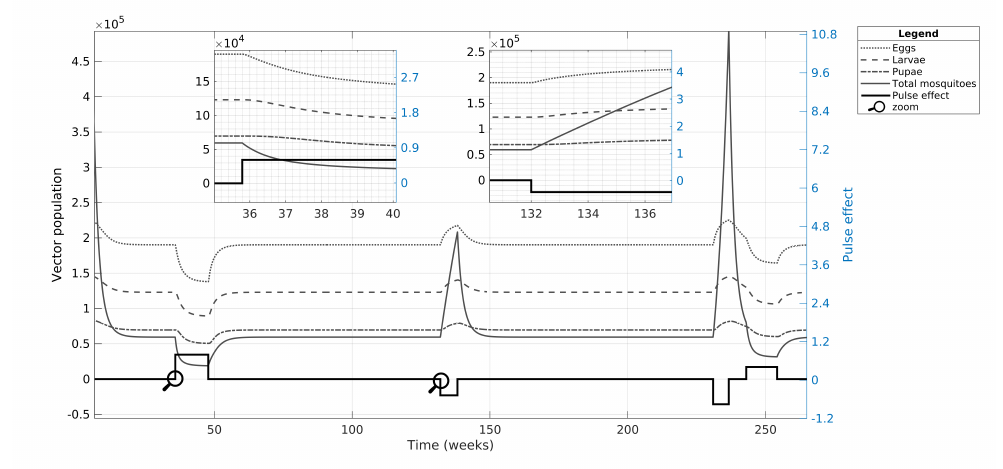
Figure 6. Simulation of case C focusing on the vector population. We used nominal values to observe how the mosquito and aquatic phases are affected by pulse-type inputs. The simulation began in week five because of the quick and significant decrease of the state variables in the vector population. The amplitude of the pulses in the plots is amplified by a factor of 10 for better